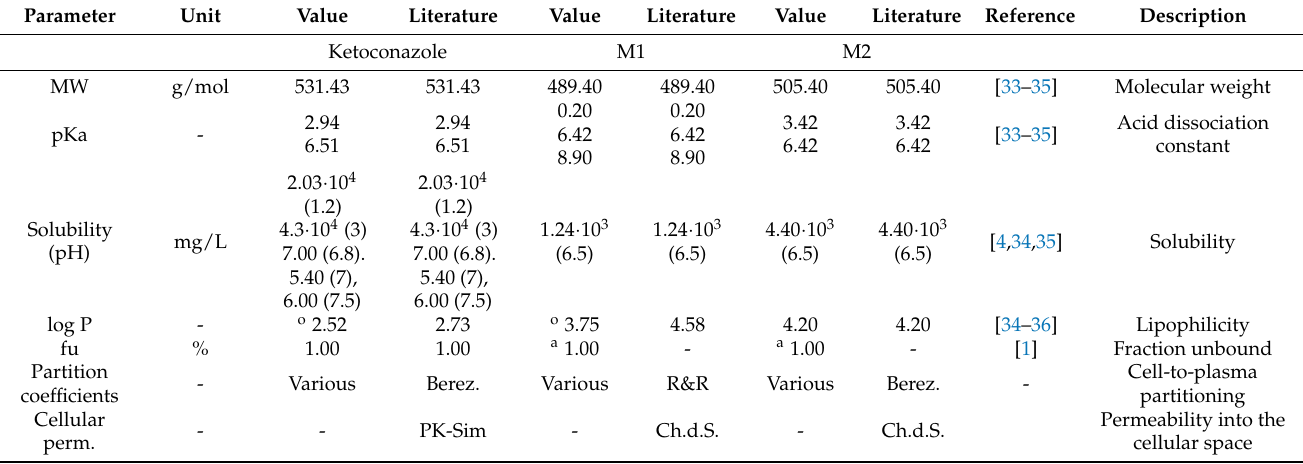
Table 1. Drug-dependent parameters of the parent–metabolite PBPK models for ketoconazole, M1 and